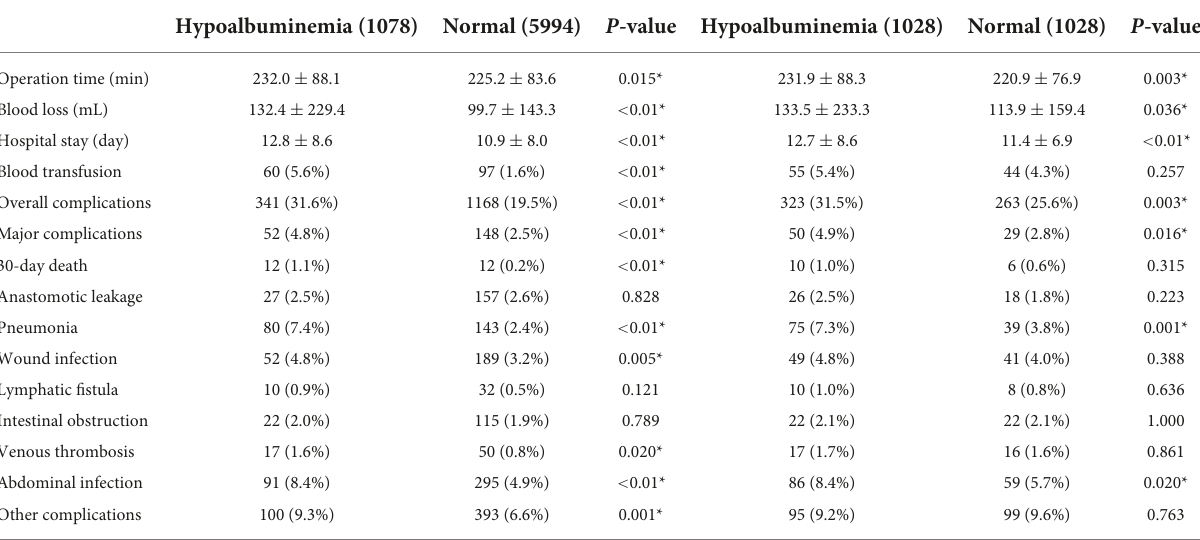
TABLE 2 Short-term outcomes before and after PSM. Characteristics